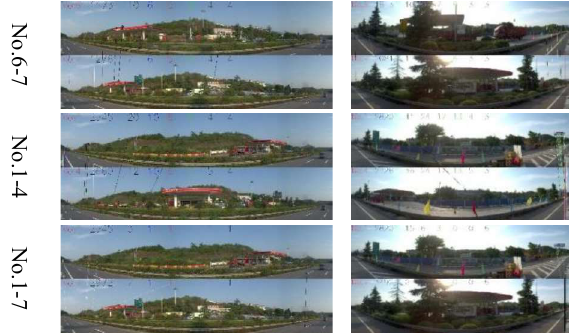
Figure 8 . Feature points matching of 3 pairs in dataset The feature points of 7 panoramic images in datas extracted and matched. Similar with dataset I, the discontinuous pairs also can be used, here, set Q=1000 and T=0.5. If the matching points after filtering are insufficient, the feature points are used directly. Figure 8 shows the matching results of three image pairs, No.6-7 is a continuous pair, which have high similarity and easy to match. No.1-7 has the largest spacing and worst similarity, the road lane and moving platform points are mismatching points in the left and right sides, even if the er is guarantee, the parameters in ROM cannot be solved